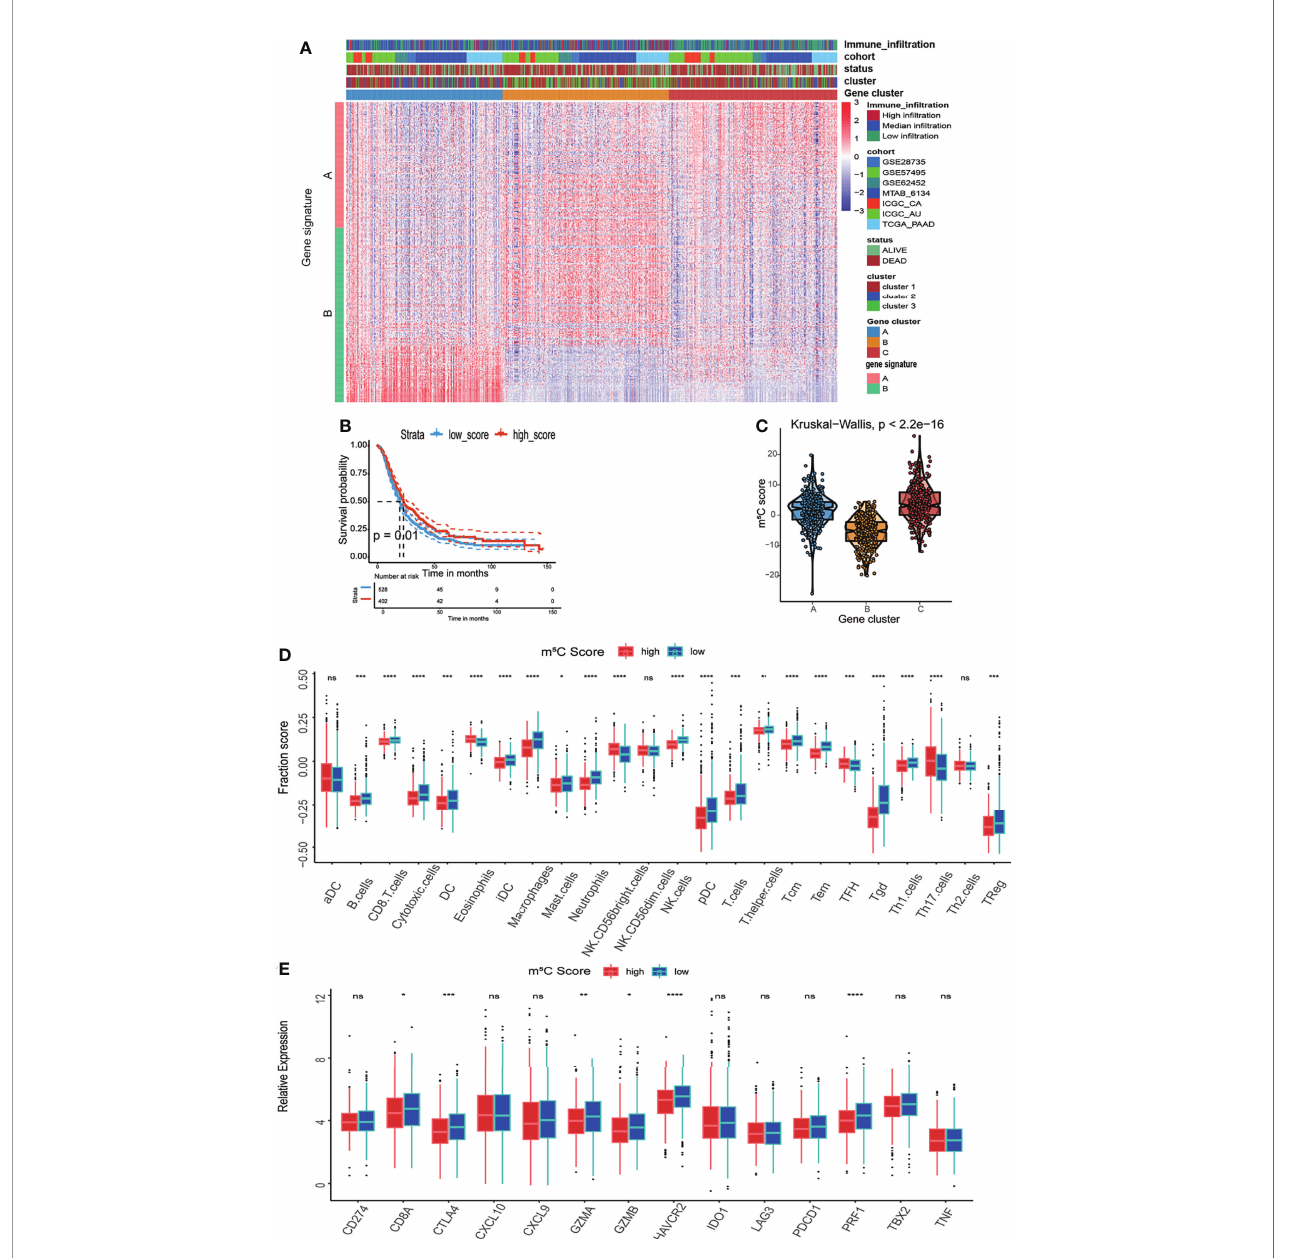
FIGURE 5 | Development of the m 5 C score and assessment of its relationship with the immune microenvironment. (A) Unsupervised clustering of 1720 DEGs between the three m 5 C gene clusters and identi fi cation of m 5 C gene signature A and B. (B) Kaplan – Meier curves of overall survival (OS) for patients with PAAD in the high and low m 5 C score subtypes. (C) Correlation between the m 5 C score and the m 5 C gene clusters. (D) Immune cell in fi ltration in the high and low m 5 C score subtypes. (E) Expression levels of immune activation-related genes and immune checkpoint-related genes in the high and low m 5 C score subtypes. * represents p value < 0.05, ** represents p value < 0.01, *** represents p value < 0.001, **** represents p value < 0.0001, ns means "not statistically signi fi